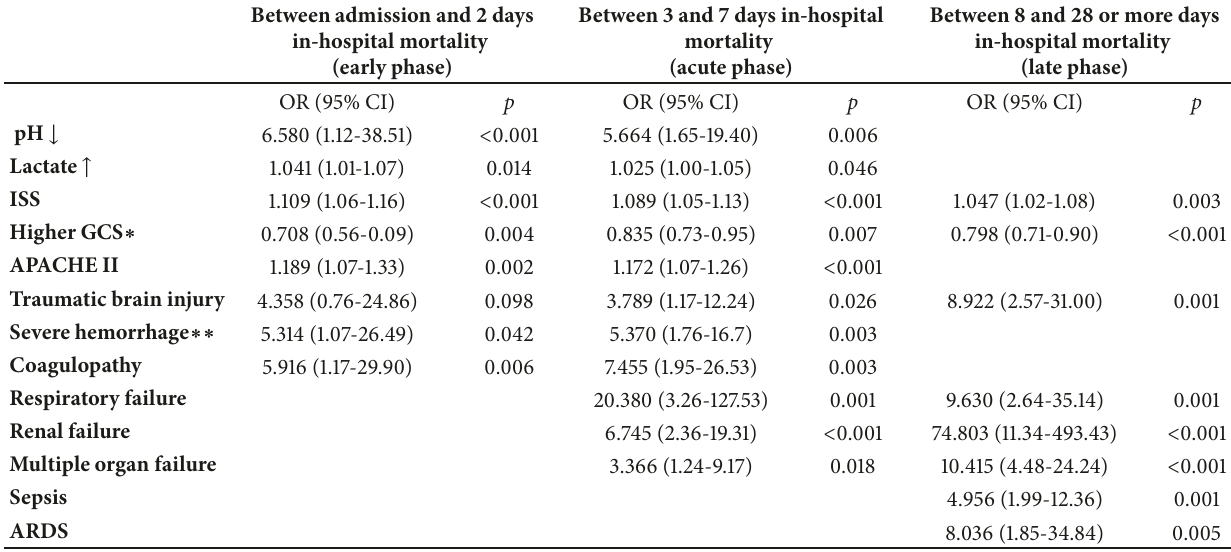
Table 7: Results of logistic regression analysis of risk factors for 2, 7, and 28 or more days in-hospital mortality for the patients with multiple